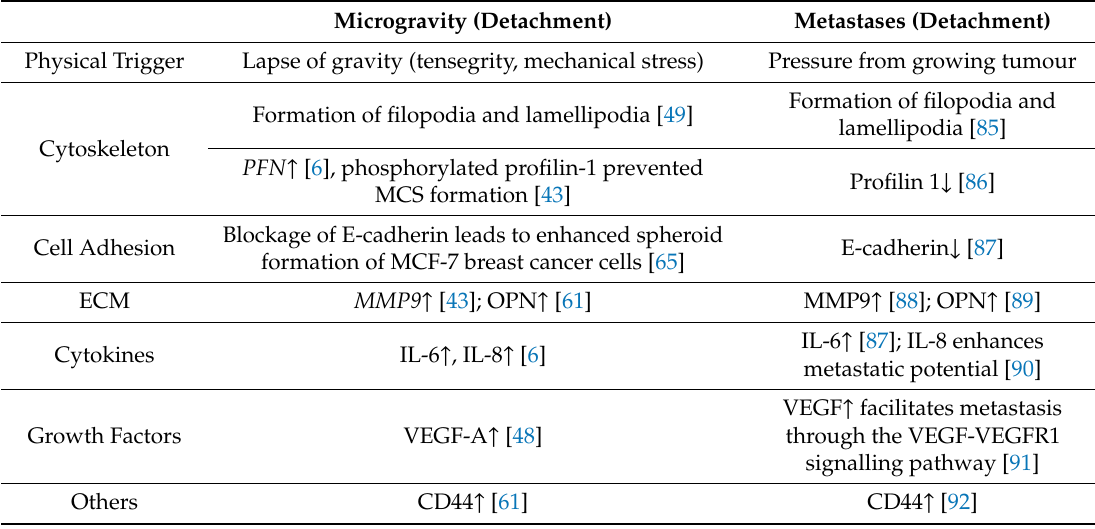
Table 3. Comparison between exposure to µ g and